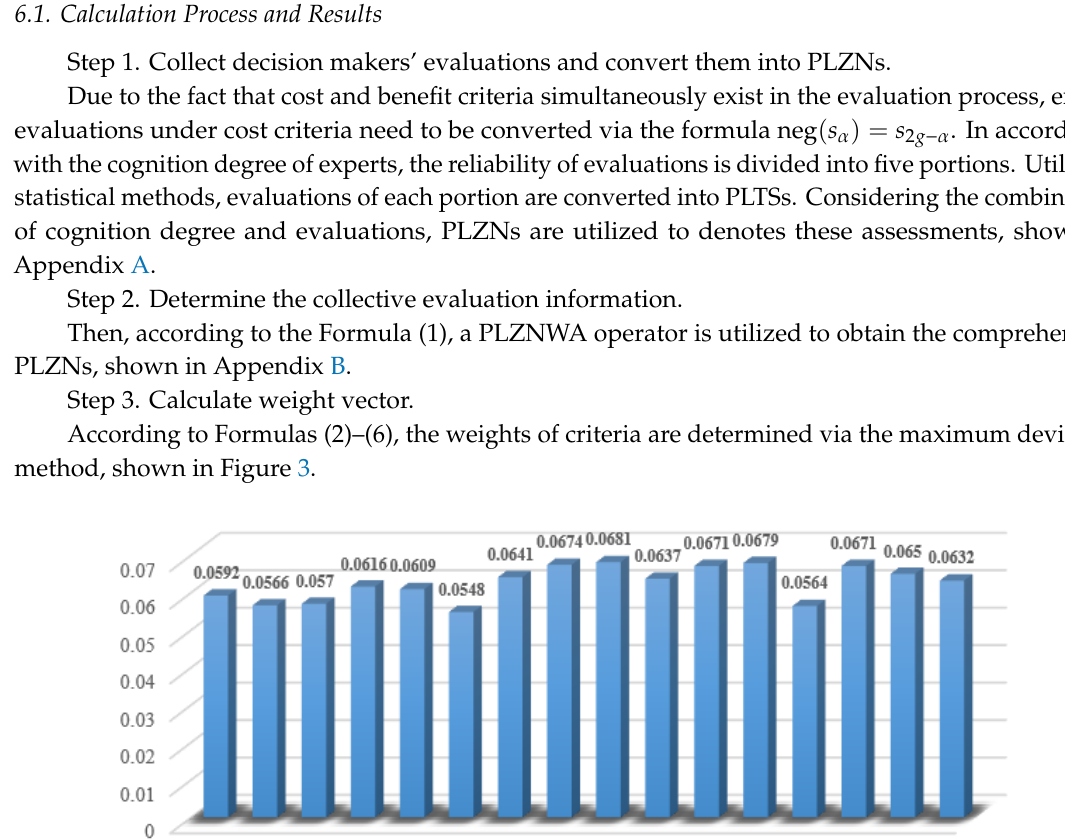
Figure 2. The maps of pilot regions.